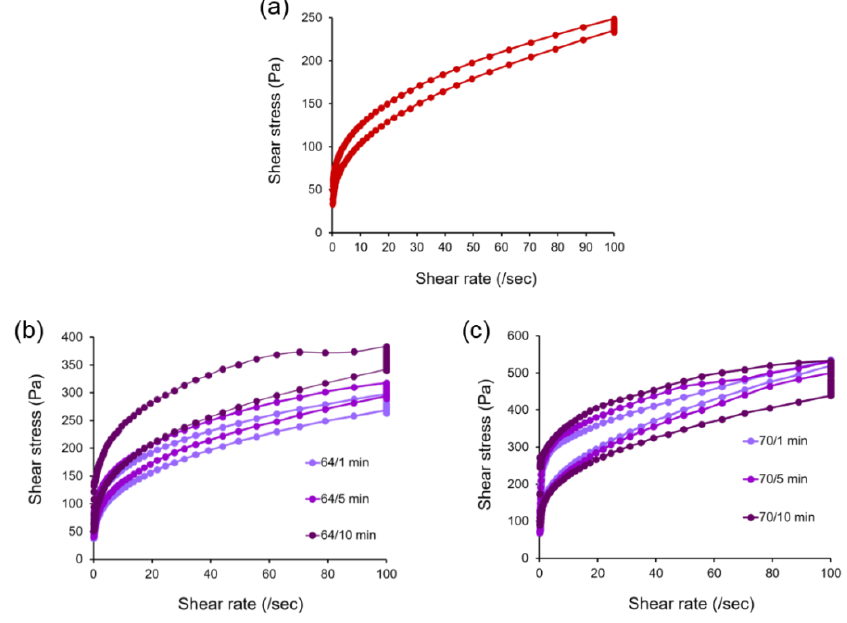
Figure 3. Effect of thermally processed LEY on mayonnaise shear stress. ( a ) Control. ( b ) Temperature at 64 ◦ C for 1, 5, and 10 min. ( c ) Temperature at 70 ◦ C for 1, 5, and 10 min. A scatter chart was used to compare at least two sets of values of